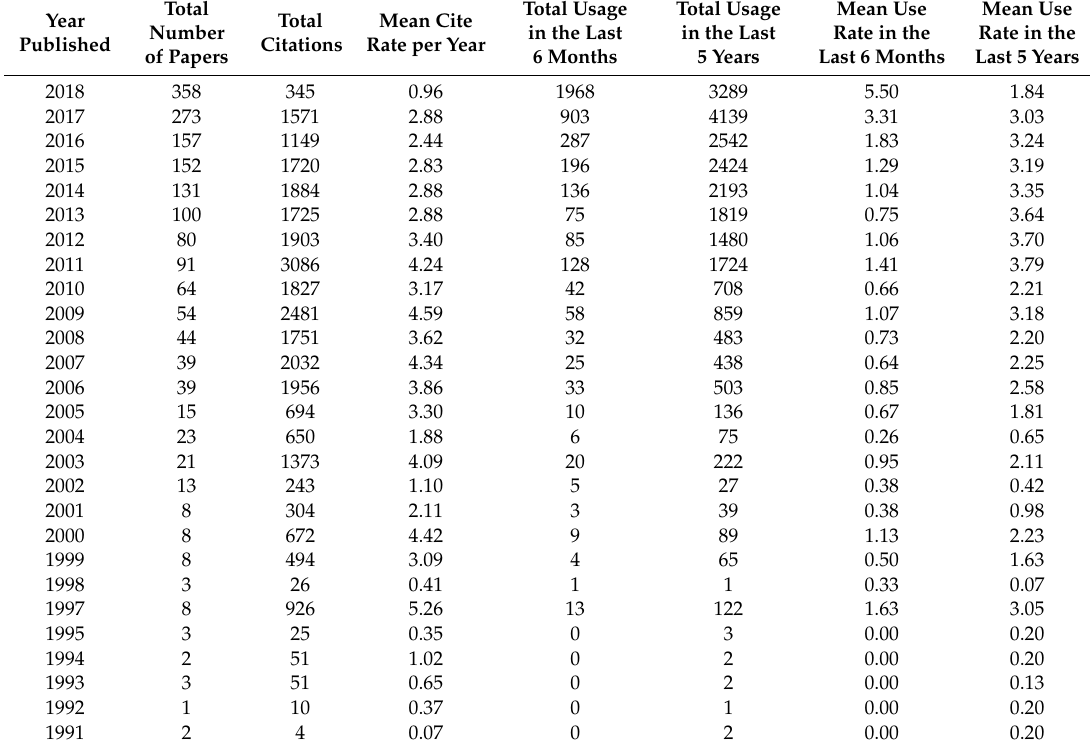
Table 2. General characteristics of